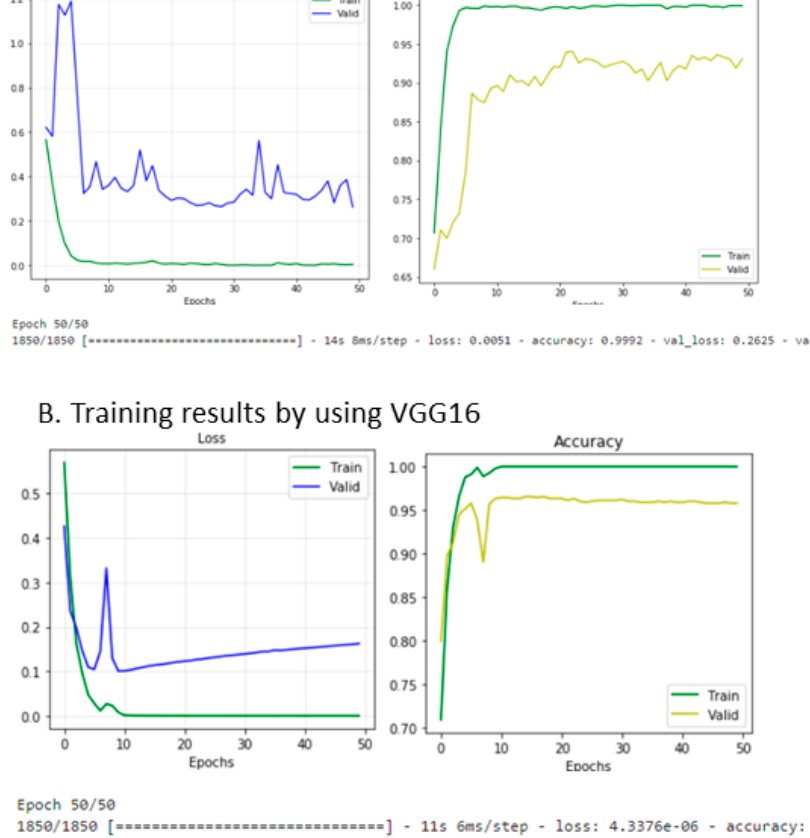
Figure 1. Results of the neural network learning for classification of the progression pattern. This figure shows the results of neural network learning to classify the “diffuse” progression pattern. The training results of the modified pretrained ResNet50 are shown in ( A ), with the changes in loss (left) and accuracy (right) indicated after every epoch. The results of the modified pretrained VGG16 model are shown in ( B ).